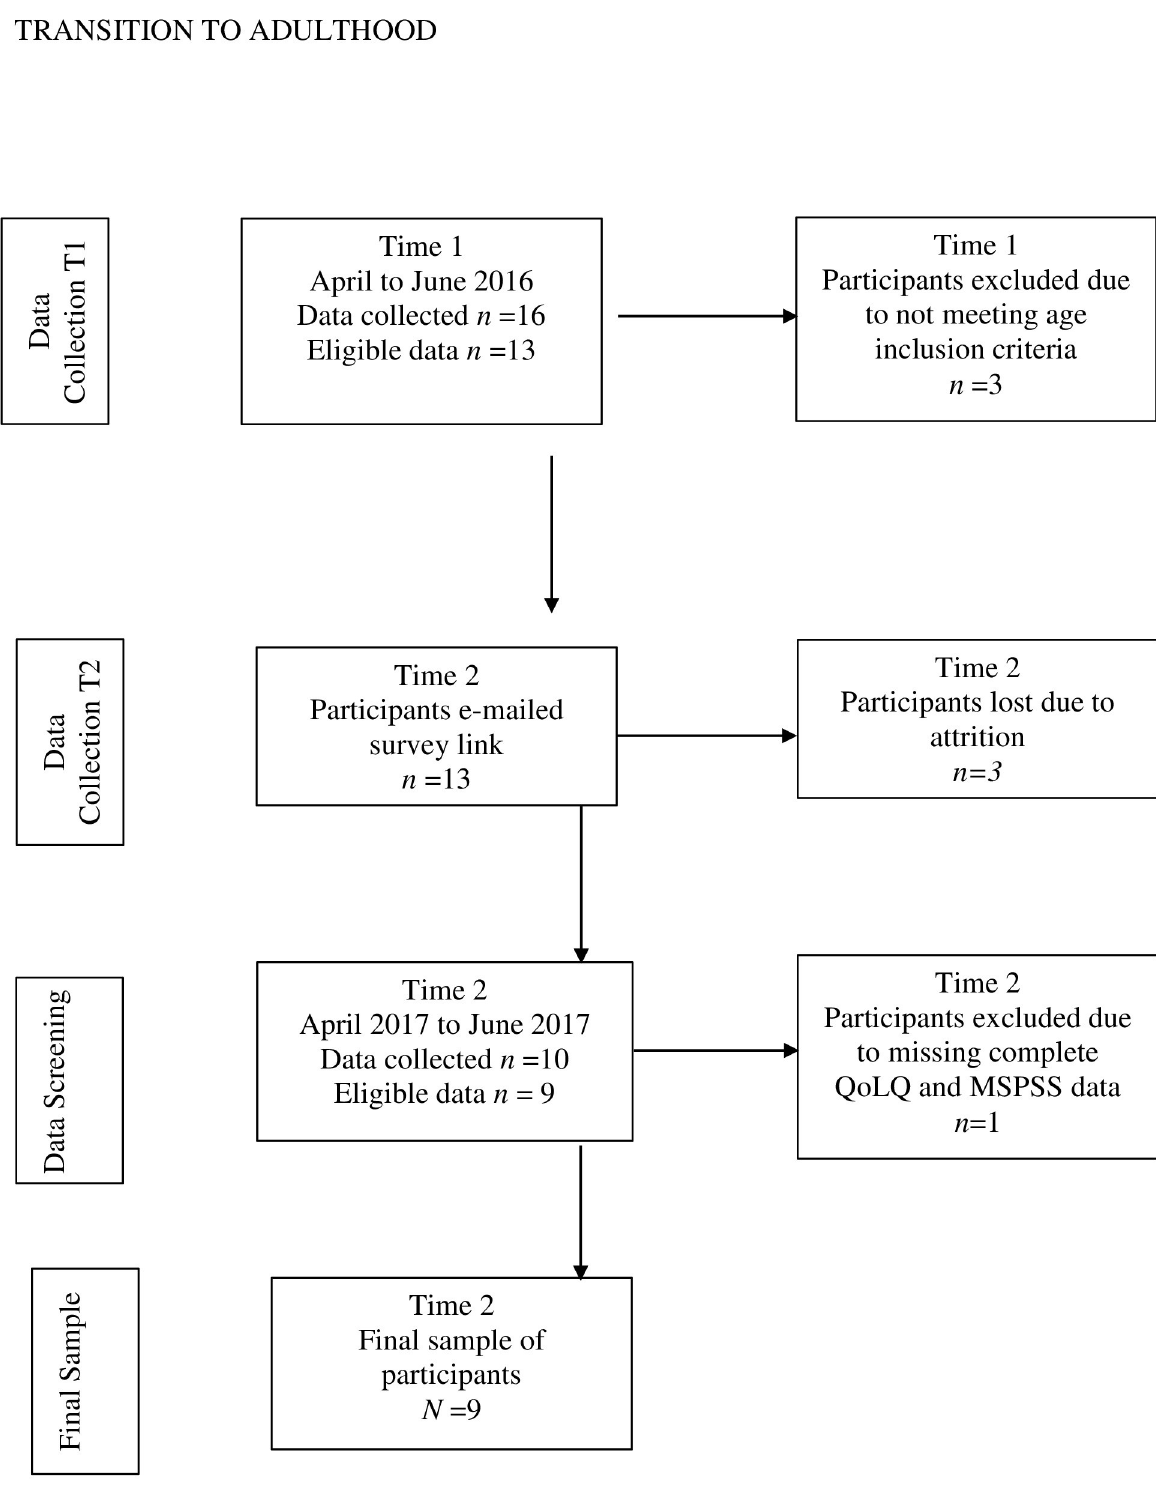
Fig 1. Flowchart of data collection process at Time 1 (T1) and Time 2 (T2).